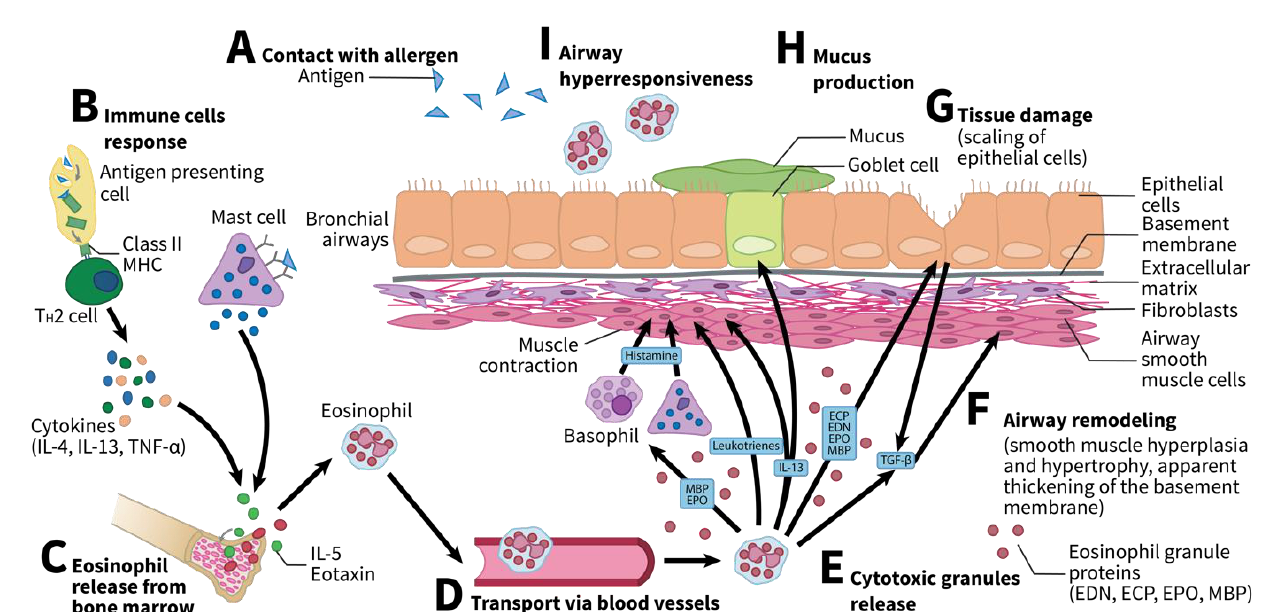
Figure 1. Upon allergen inhalation, several steps lead to eosinophil release. ( A ) After contact with an allergen, the antigens are absorbed by antigen presenting cells (APC) or mast cells. ( B ) APC in turn produces major histocompatibility complex II (MHC II) class molecules, allowing for T H 2 cells to further release cytokines such as interleukin (IL)-4, IL-13, or tumor necrosis factor alpha (TNF-α). ( C ) Combined with mast cells, IL-5, and eotaxin, they promote eosinophil release from bone marrow. ( D ) Eosinophils are then transported through the vasculature to airways, where they accumulate. ( E ) They then release cytotoxic granules. ( F ) Tissue damage, as well as eosinophil recruitment, promote the release of TGF-β, which, in turn, promotes airway remodeling. ( G ) Eosinophils also promote tissue damage by releasing cytotoxic granules (eosinophil cationic proteins [ECP], eosinophil-derived neurotoxin [EDN], eosinophil peroxidase [EPO], and major basic proteins [MBP]). ( H ) They can promote excessive mucus secretion by goblet cells when releasing IL-13. ( I ) Similarly, they promote airway hyperresponsiveness either by releasing MBPs and EPO to promote the release of histamine by basophils and mast cells or directly by releasing leukotrienes or IL-13. EDN, eosinophil-derived neurotoxin; ECP, eosinophil cationic protein; EPO, eosinophil peroxidase; IL, interleukin; MBP, major basic protein; TGF-β, transforming growth factor beta; TNF-α, tumor necrosis factor alpha. Adapted from Possa et al . and McBrien et al . [14,30].